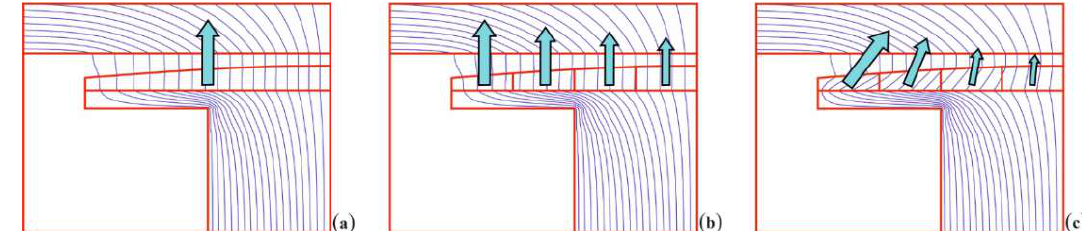
Figure 9. Magnetic pole of SM with constant magnetization in the y -direction-initial configuration ( a ); PM divided into 8 parts with optimized magnetization in the y -direction ( b ); PM with optimized magnetization in both directions ( c ). The comparison of the initial, required, and obtained field distributions is given in Figure 10.